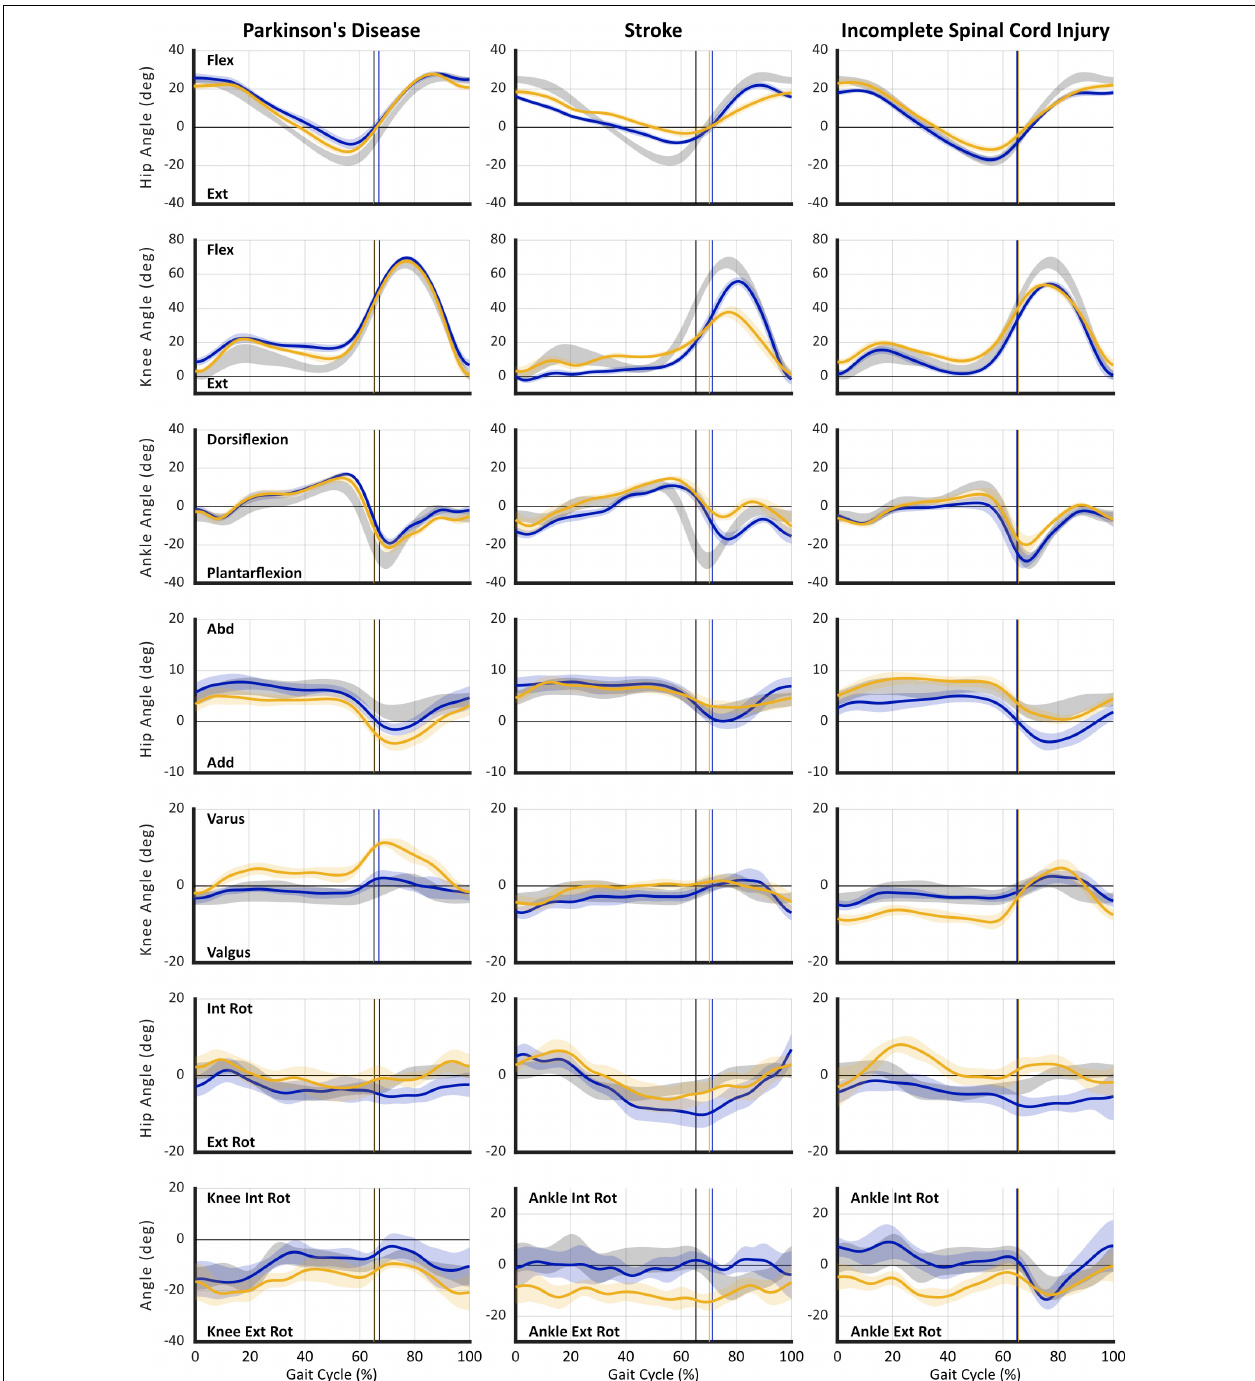
FIGURE 3 | Gait kinematics acquired using markerless motion capture during self-selected (SS) walking task. Plots are presented in columns for: (1) Case 1 – Parkinson’s disease (PD), (2) Case 2 – Stroke, and (3) Case 3 – incomplete Spinal Cord Injury (iSCI). Joint angle curves are presented in rows: (1) hip sagittal plane (flexion/extension), (2) knee sagittal plane (flexion/extension), (3) ankle sagittal plane (dorsiflexion/plantarflexion), (4) hip frontal plane (abduction/adduction), (5) knee frontal plane (varus/valgus), (6) hip transverse plane (internal/external rotation), and (7) transverse plane (internal/external rotation) angles for: knee – Case 1 | PD, or ankle (Cases 2–3) | Stroke and iSCI. For all plots: gray shaded area reflects reference control group ensemble average (SD); gold individual subject right leg; and blue individual subject left leg. Vertical cursor at ∼ 63% gait cycle denotes toe off for the respective group or leg. Individual subject curves falling outside reference range can be interpreted as gait deviations. Visualization of data across multiple concurrently occurring joint angles/axes enables interpretation of causal mechanisms of gait dysfunction and informs targeted rehabilitation interventions. Furthermore, longitudinal studies enable use of gait kinematics as a sensitive outcome measure specific to the individual’s impairments. All data were acquired using markerless motion capture (Theia3D) with participants wearing their usual attire and footwear.